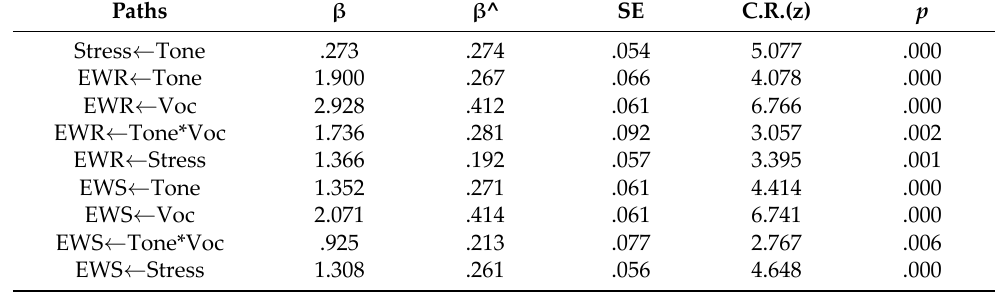
Table 6. Moderated Structural Equation Modeling: Effects of Tone, Stress, Vocabulary, Tone*Stress Interaction on English Word Reading and Spelling Performance.